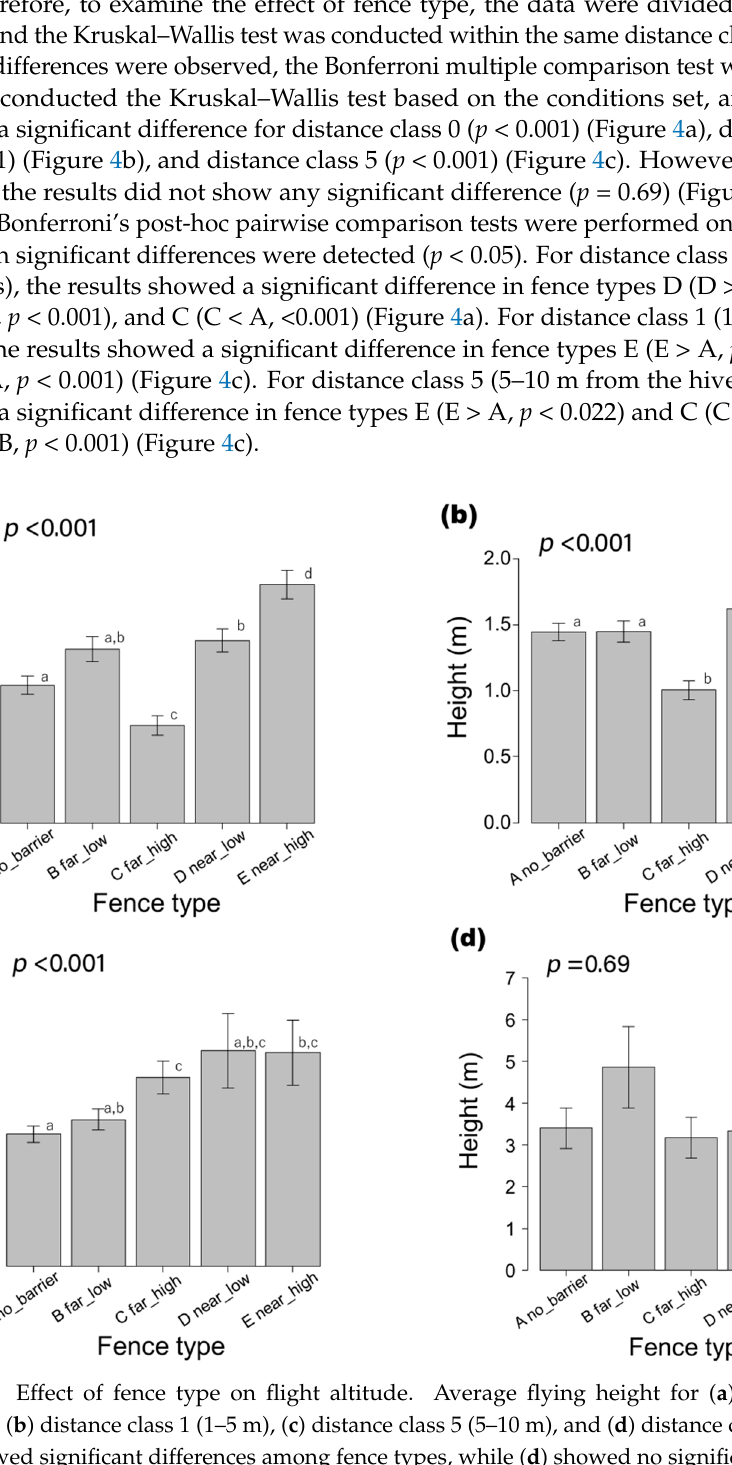
Figure 3. Difference in flying height by ( a ) fence type and ( b ) distance class. Letters above the error bars represent the results of Bonferroni’s post-hoc pairwise comparison test. Error bar heights are means ± standard error.